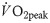
Ski jumping (SJ) and cross-country (XC) performance in relationship to the sport-specific capacities that combined best explained the variance in performance, as well as overall performance in relationship to the SJ and XC performance for the 12 international Nordic combined world-cup athletes.The data points represent the top 3 ranked ski jumpers (□ SJtop3), top 3 ranked XC skiers (Δ XCtop3), and the remaining 6 athletes of the study (● n = 6). The lines were obtained by linear regression. VvIMIT = maximum achieved vertical velocity of the skier in imitation jump; V˙O2peak = peak oxygen uptake from incremental test to exhaustion; DP = double poling; UB LM = upper-body lean-mass.